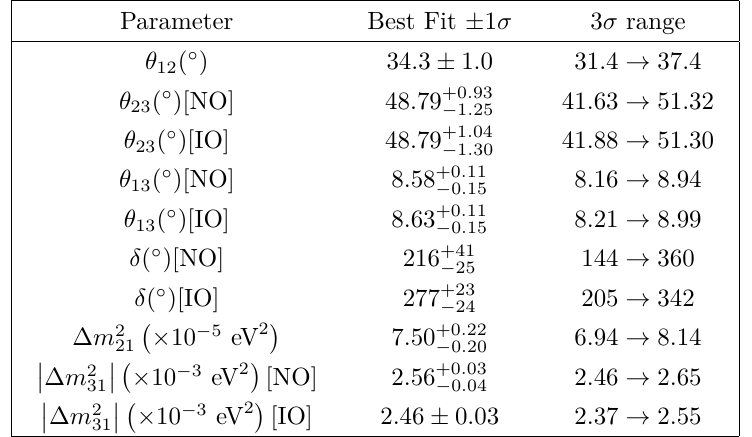
Table 1 . Current neutrino data obtained from the global fit of three flavour oscillation parame- ters